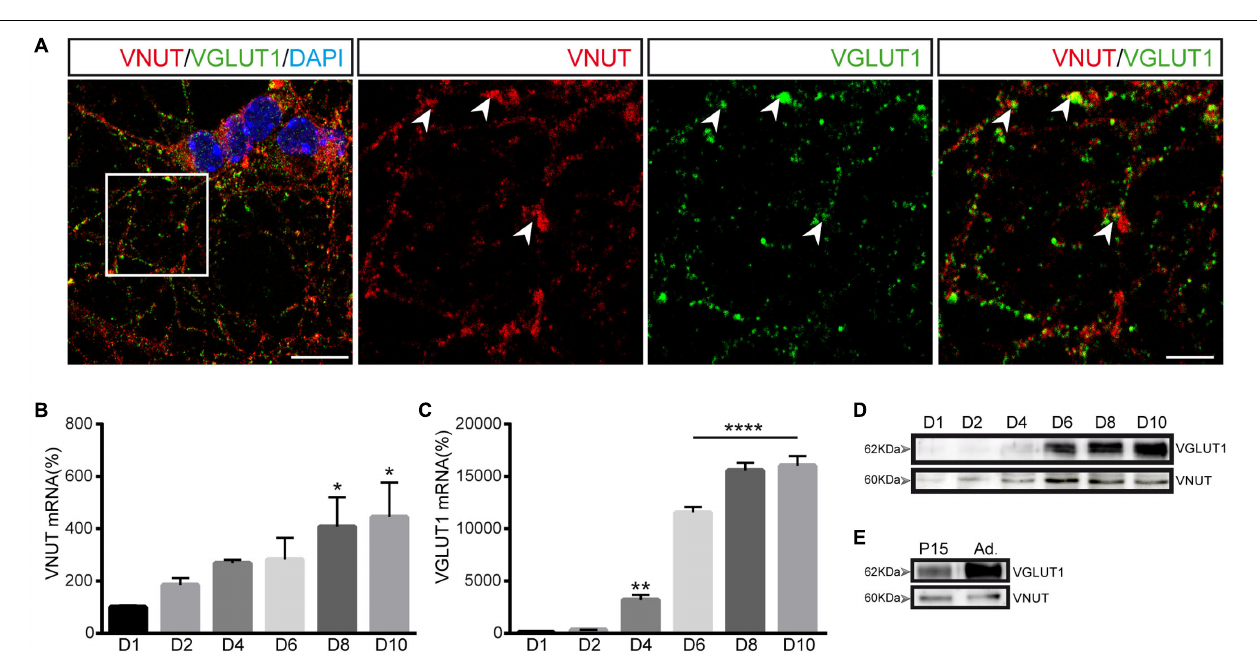
FIGURE 4 | Distribution of VNUT or VGLUT1 in a single cerebellar granule cell. Representative confocal images showing the immunostaining for MAP2 (green), SMI 312 (blue) and either VNUT (red, upper panels) or VGLUT1 (red, lower panels). Scale bar: 15 µ m. The insets represent higher magnifications of the somatodendritic or axonal compartments. Scale bar: 2.5 µ m.